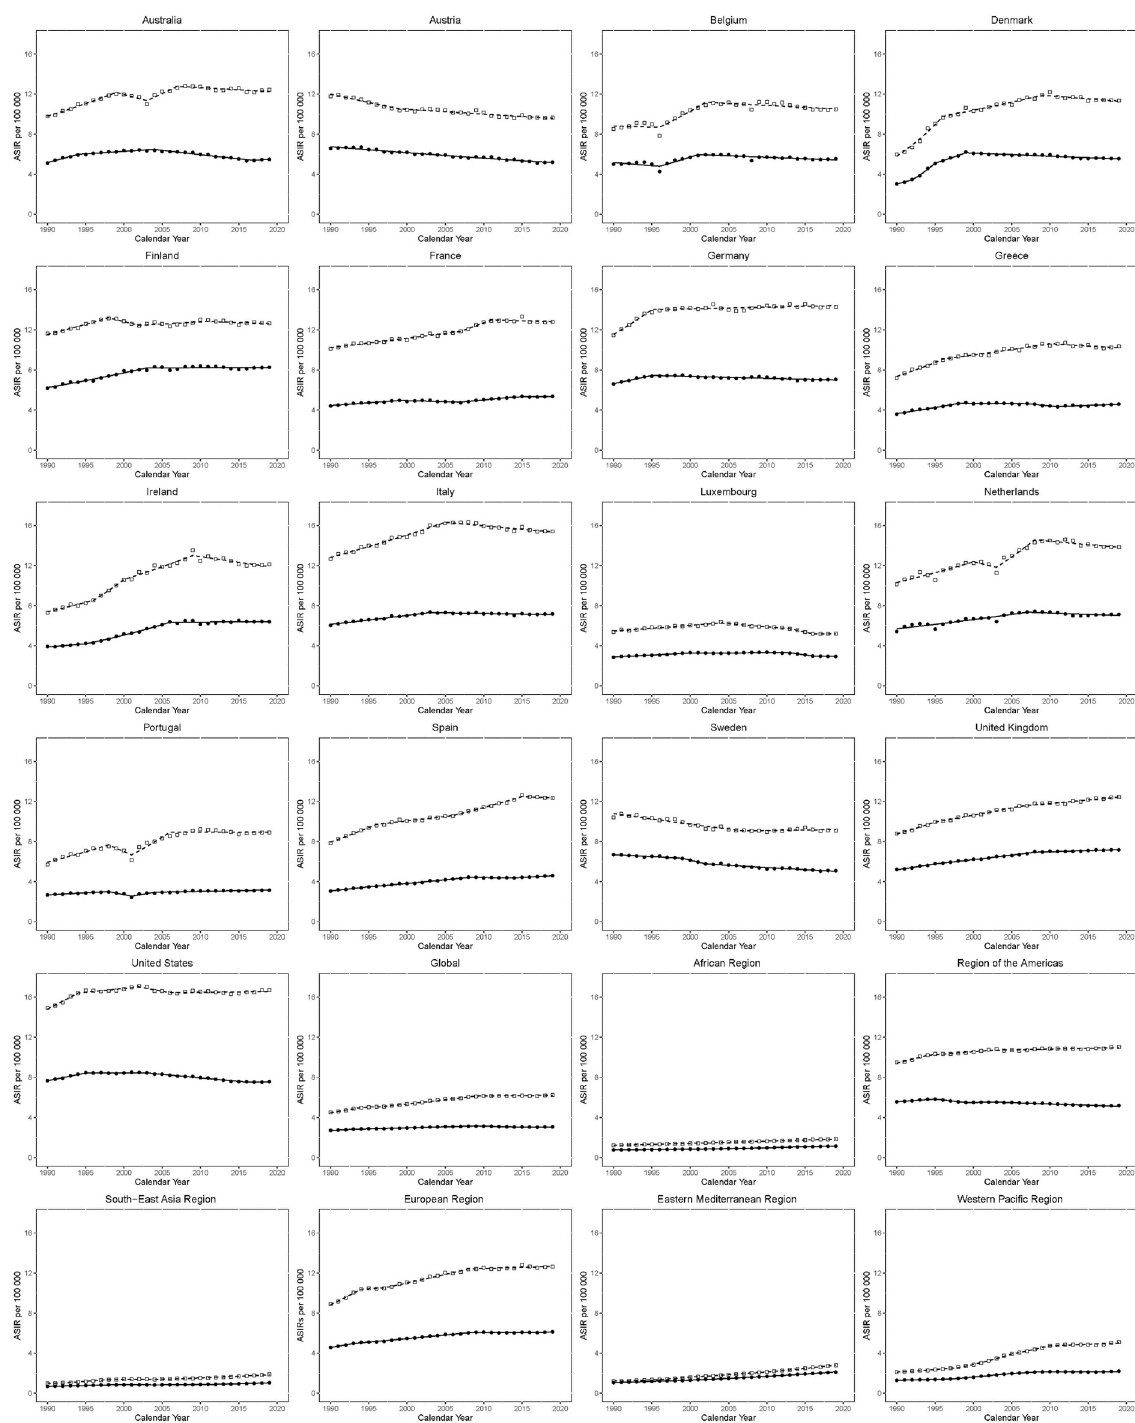
Figure 3. Trends in age-standardized incidence rates (ASIR) per 100,000 for KC in EU15 + countries and WHO regions between 1990 and 2019. Open squares indicate males; and filled circles, Across the 29-year study period, there was a rise in DALYs globally for males (+ 13.1%) and a fall for females (− 9.4%). Similar trends were seen across all six regions as well. The Eastern Mediterranean region saw the greatest increase for males (+ 76.6%), whereas the Americas saw the smallest rise (+ 2.1%). Apart from the Americas (− 23.5%), all regions saw a rise in DALYs for females, led by the Eastern Mediterranean region (+ 36.3%). In the EU15 + countries, Denmark saw the greatest rise in DALYs for both males and females, + 38.6% and + 30.2 respectively. Austria saw the greatest decrease in DALYs across the study period for males and females,